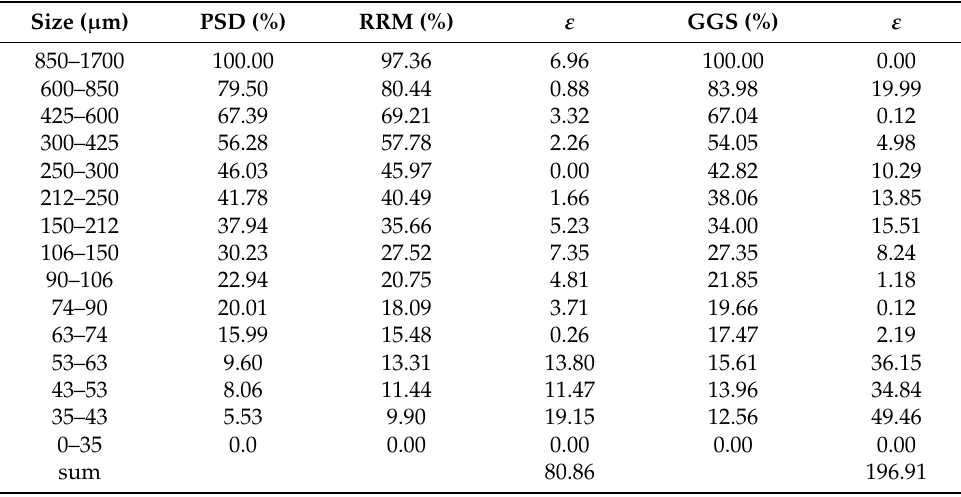
Table A2. Adjustment results of the PSD and PSDM with least squares, for 4